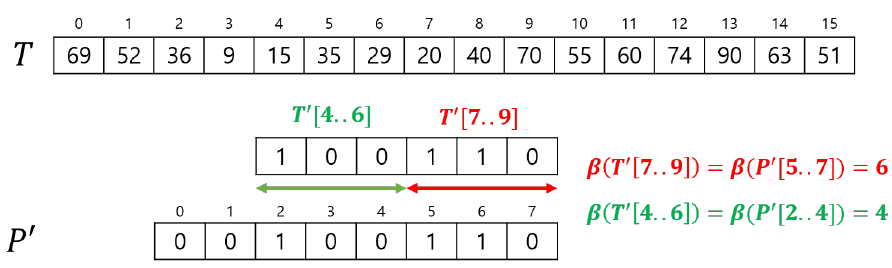
Figure 1. Order-preserving pattern matching using fingerprints of the primary q -gram and the secondary q -gram when q =